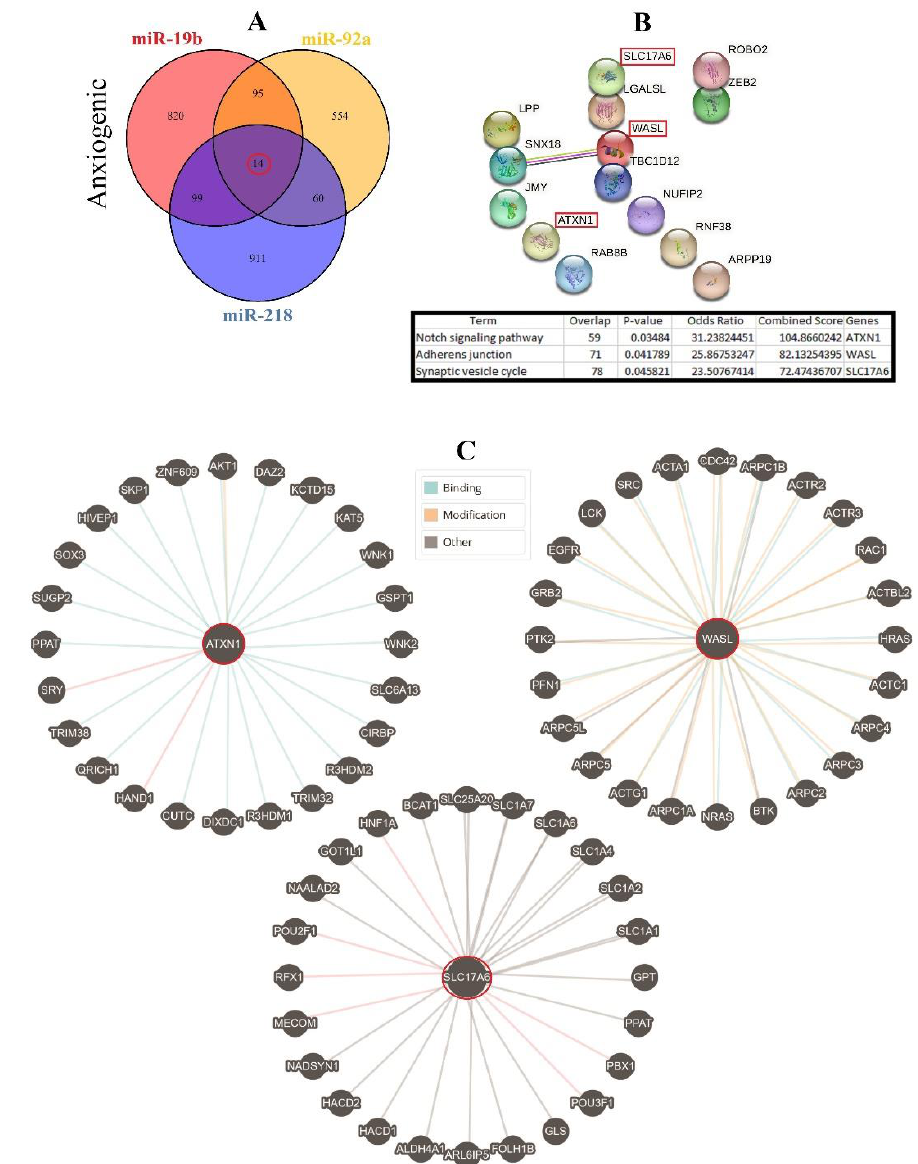
Figure 3. Common gene targets of highlighted anxiogenic miRNAs (miR-19b, miR-92a, and 218), their PPI, and protein targets. ( A ) Target prediction of highlighted anxiogenic miRNAs and selection of shared genes. ( B ) PPI of 14 common genes and selection proteins with a higher rank (SLC17A6, WASL, and ATXN1). Hub genes were determined via the KEGG database in Enrichr, and information is indicated in a table. ( C ) Protein interaction of anxiogenic’s common gene targets with other proteins.